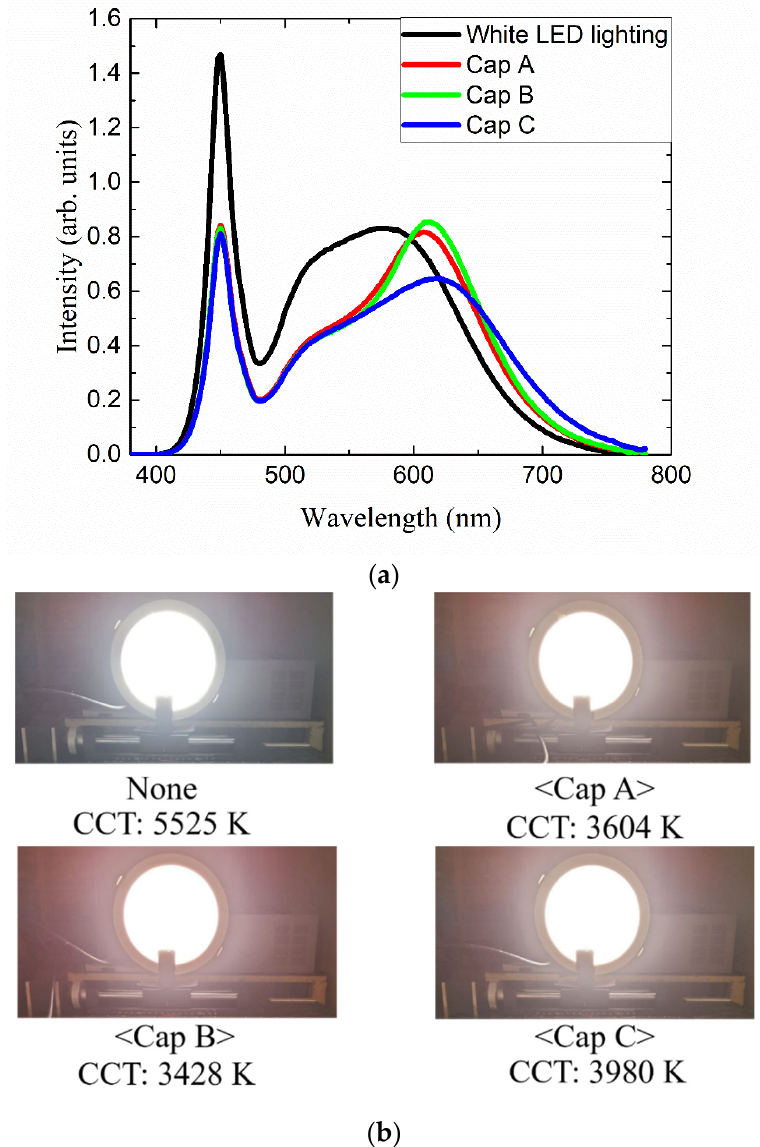
Figure 8. ( a ) Emitting spectra of the QD lighting adopting pattern 4 where three kinds of red QD caps have been used. “White LED lighting” indicates the original LED lighting where no QD cap was adopted. ( b ) The photographs of four LED lights demonstrating the change in color shade.